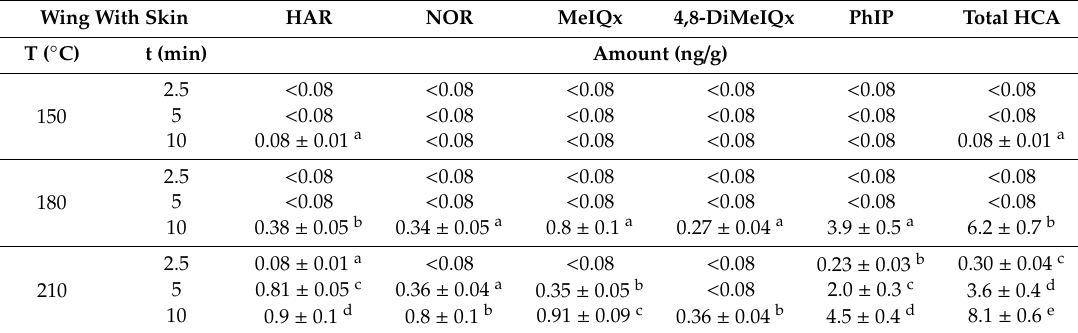
Table 5. Heterocyclic amine (HCA) content of heat-treated chicken wing with skin.